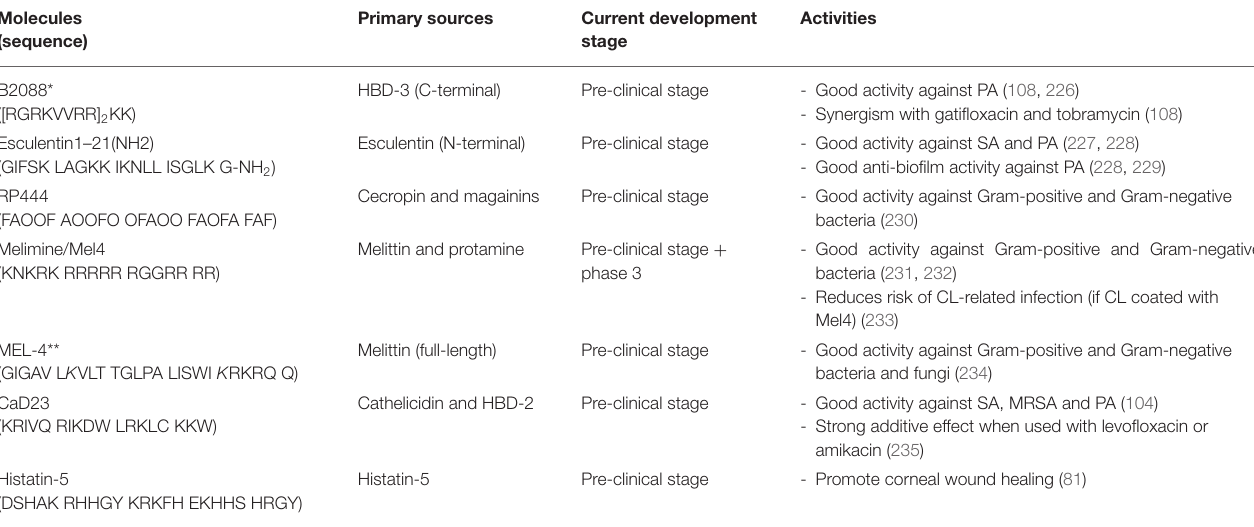
TABLE 2 | A summary of host defense peptide (HDP)-based molecules that are in the development pipeline for ocular surface diseases. Molecules Primary sources Current development (sequence)